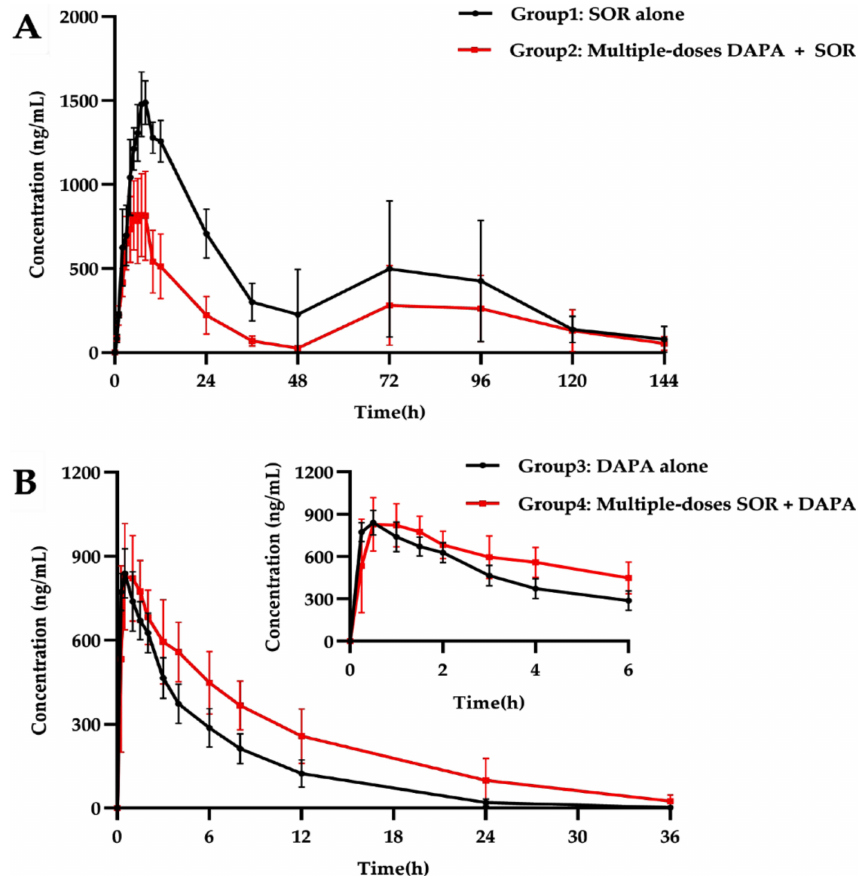
Figure 3. ( A ) The mean plasma concentration–time profiles of SOR after oral SOR alone and combined with multiple-doses DAPA. ( B ) The mean plasma concentration–time profiles of DAPA after oral DAPA alone and combined with multiple-doses